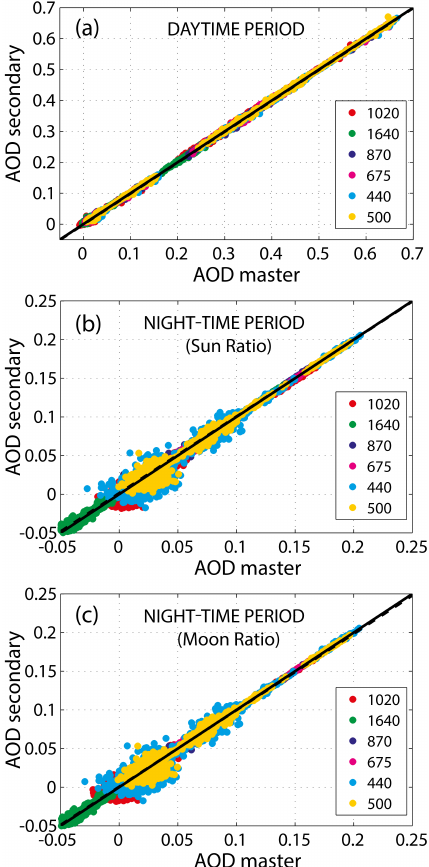
Figure 4. Scatter plot with CE318-T master- vs. secondary-derived AODs for (a) a period of 22 consecutive days and (b) and (c) for a period of 10 consecutive nights in June 2014, with the secondary instrument calibrated using the Sun Ratio and the Moon Ratio tech- niques, respectively.